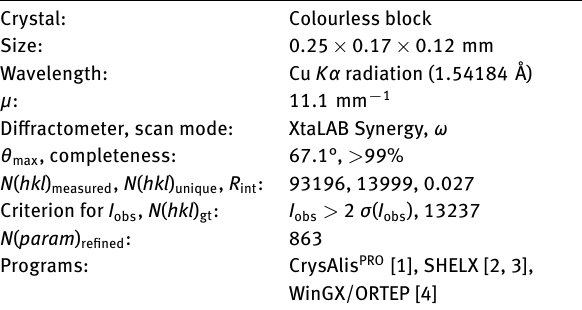
Table 1: Data collection and